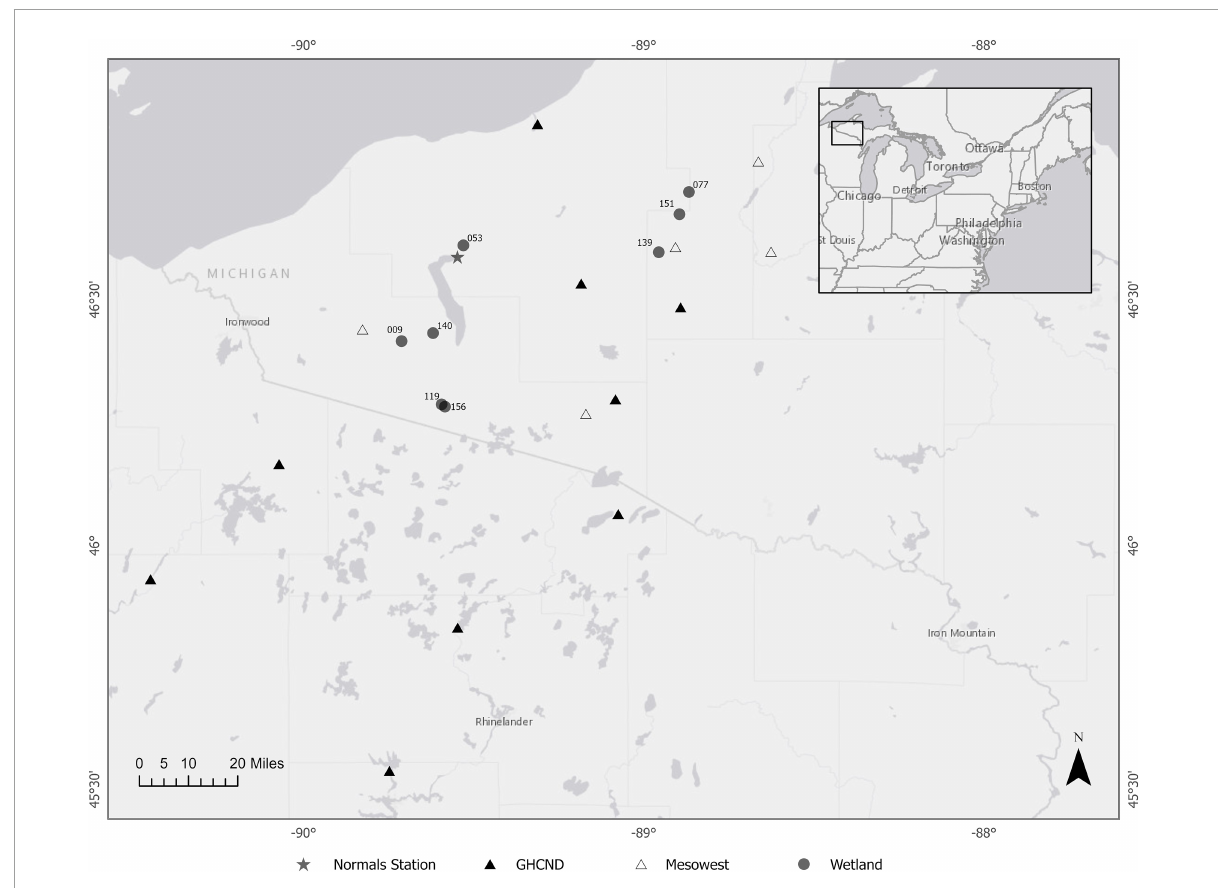
FIGURE1 Map of study site and meteorological stations of Global Historic Climate Network—Daily (GHCND), Mesowest, and Norms Station used for data retrieval. Coordinates are in meters, UTM Zone 16N.